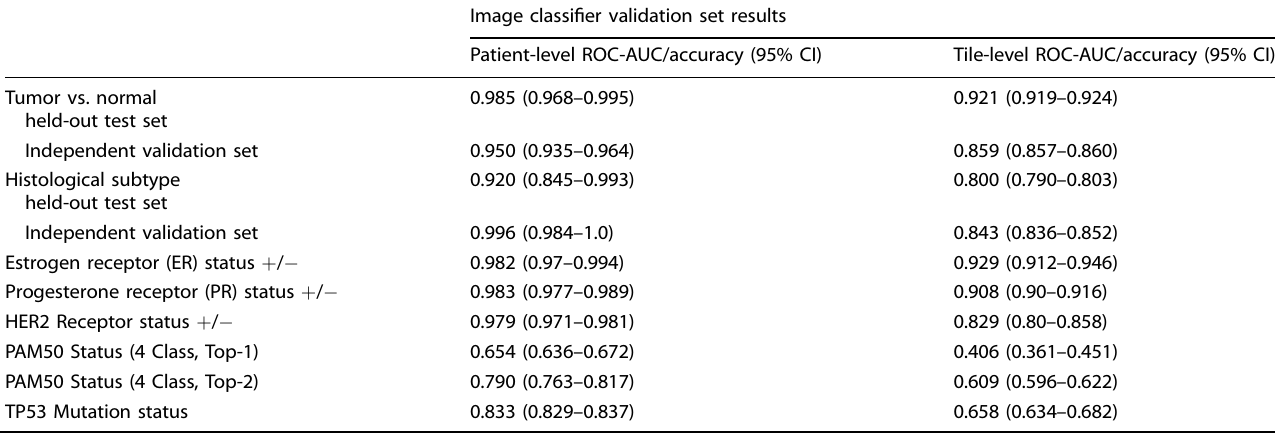
Table 2. Validation ROC-AUC (binary tasks)/accuracy (non-binary tasks) values for all image-based classi fi ers.